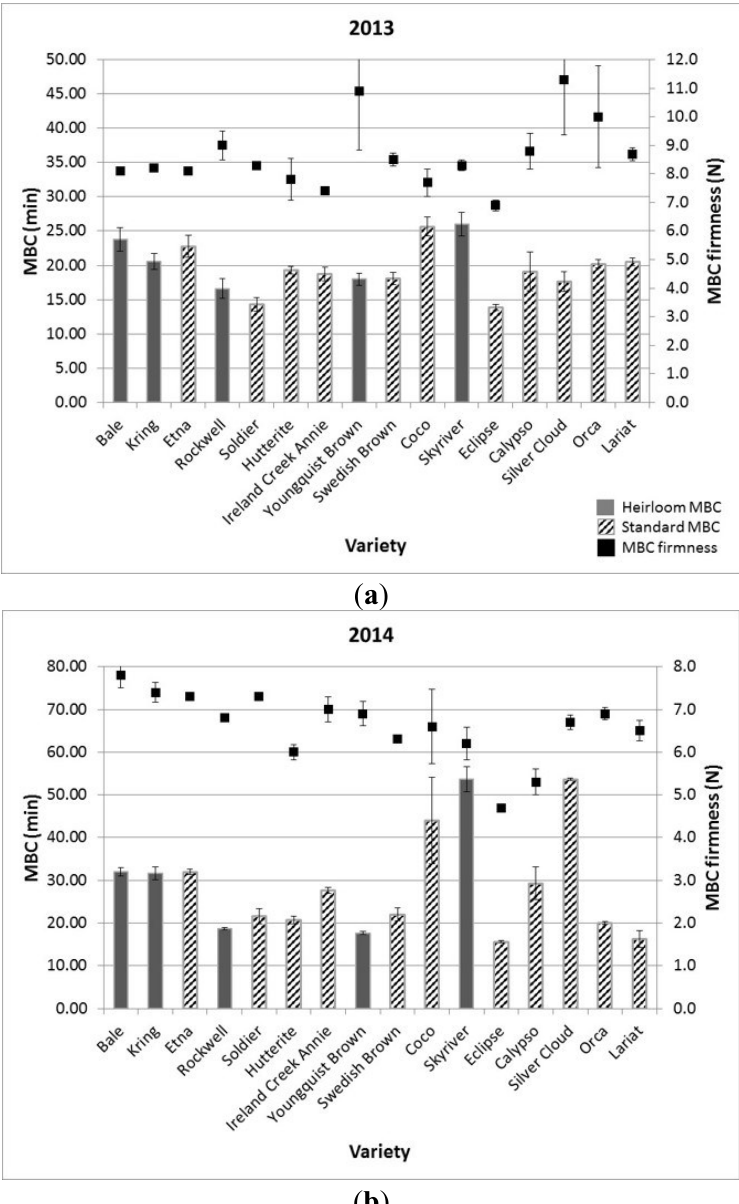
Figure 2. Mean cooking time (min) and firmness (N) using a Mattson bean cooker six months after harvest of 16 dry bean varieties grown at Washington State University Northwestern Washington Research and Extension Center, Mount Vernon, WA, USA, in 2013 ( a ) and 2014 ( b ); varieties differed significantly both years ( p < 0.0001 and p = 0.002, respectively). All data were analyzed using JMP (JMP v. 11.2.0, SAS Institute Inc.,